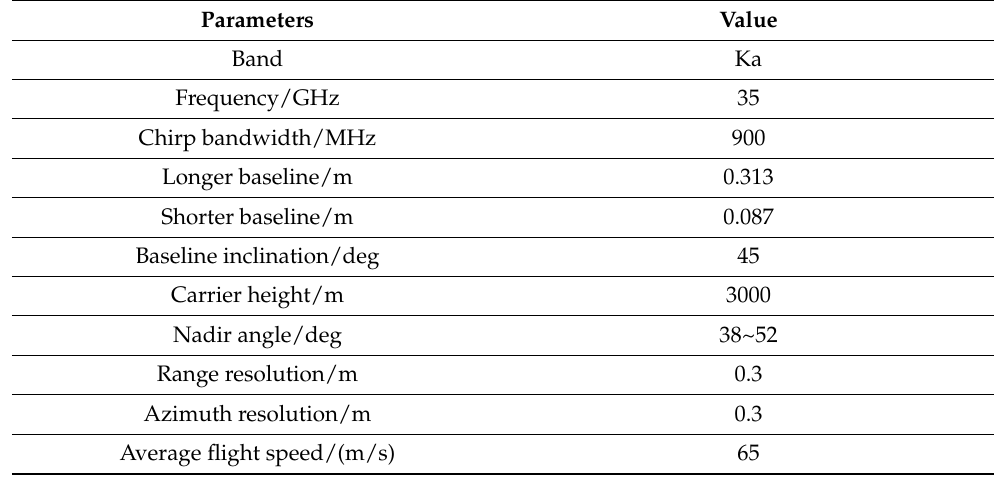
Table 1. Experimental parameters of the airborne millimeter-wave InSAR system.